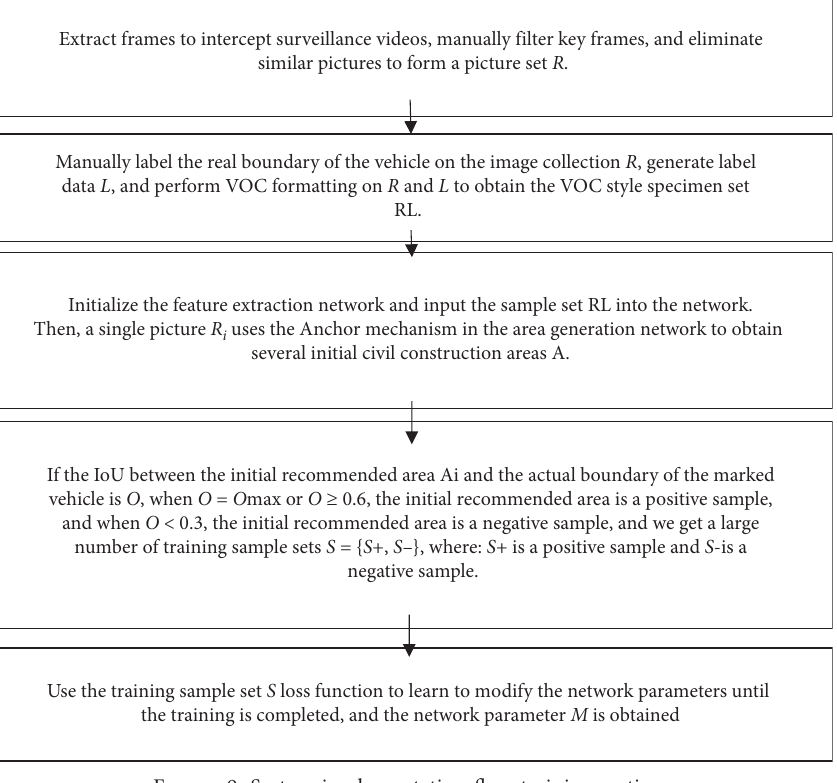
Figure 9: System implementation flow-training section.